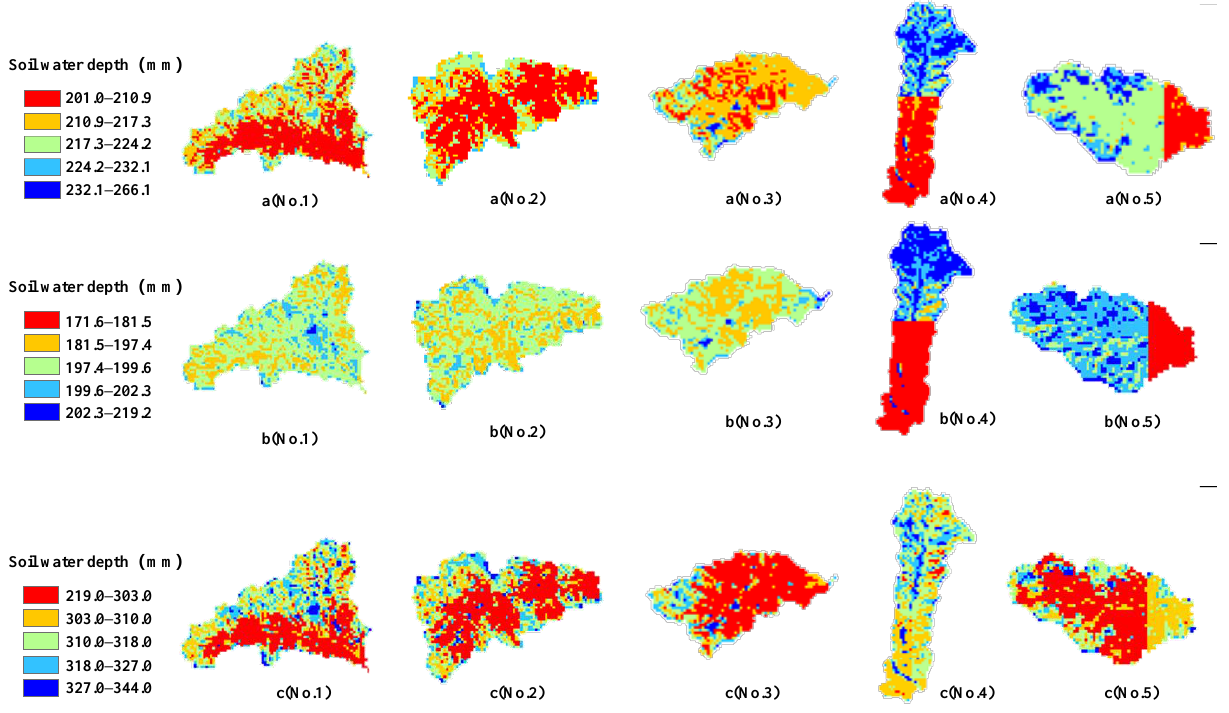
Figure 15. Simulated spatial variation of soil water in large-scale silt dams. (a = change period (1); b = change period (2); c = change period (3)).